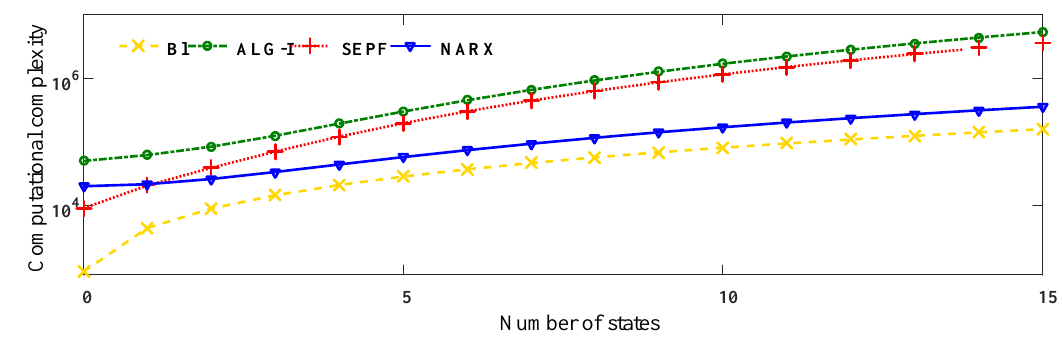
Figure 8. The computational complexity of OOSM methods: Bl, ALG-I, SEPF and NARX-based algorithms. The number of disorders is 9; the computational complexity is represented by the float